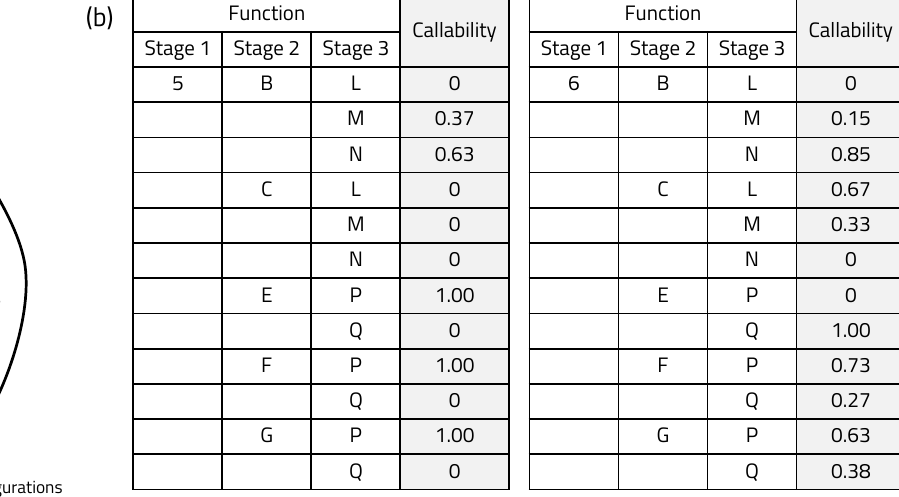
Figure 8. Application control flow and extracted